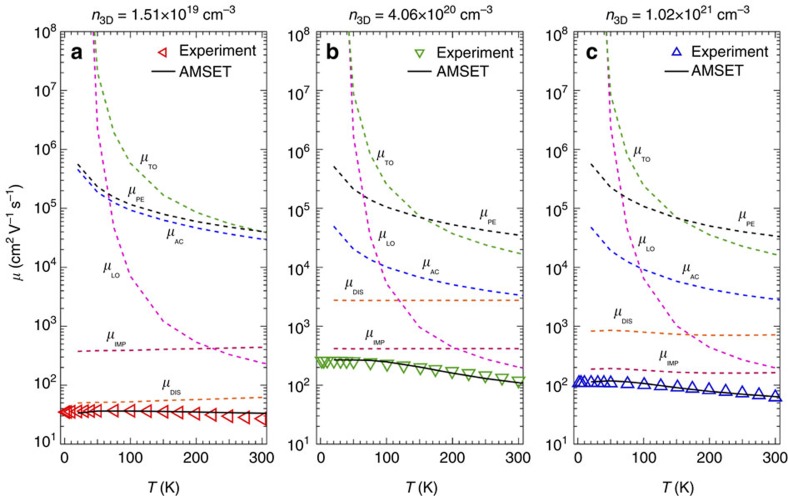
Temperature dependence of mobility and individual contributions to the mobility from different scattering mechanisms.μ versus T for doped BaSnO3 films, (a) n3D=1.51 × 1019 cm−3, (b) n3D=4.06 × 1020 cm−3, and (c) n3D=1.02 × 1021 cm−3. Contributions from different carrier scattering mechanisms are shown with dotted curves. Dislocation density as calculated from the model were—(a) ZDZDISNDIS=2.3 × 1012 cm−2, (b) ZDZDISNDIS=7.0 × 1011 cm−2, and (c) ZDZDISNDIS=2.8 × 1012 cm−2 respectively for the three samples, where ZD and ZDIS are the overall charge states of the donors and charged dislocations respectively. See method section for more details.